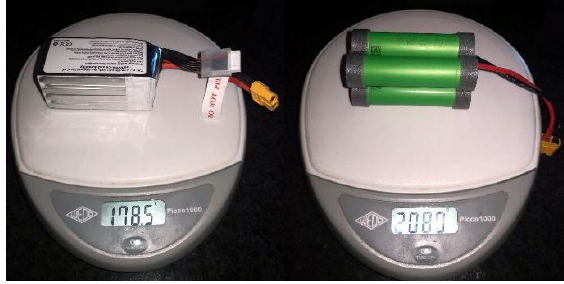
Figure 5: comparison of Lithium Ionic cells and underneath Lithium Polymer pack